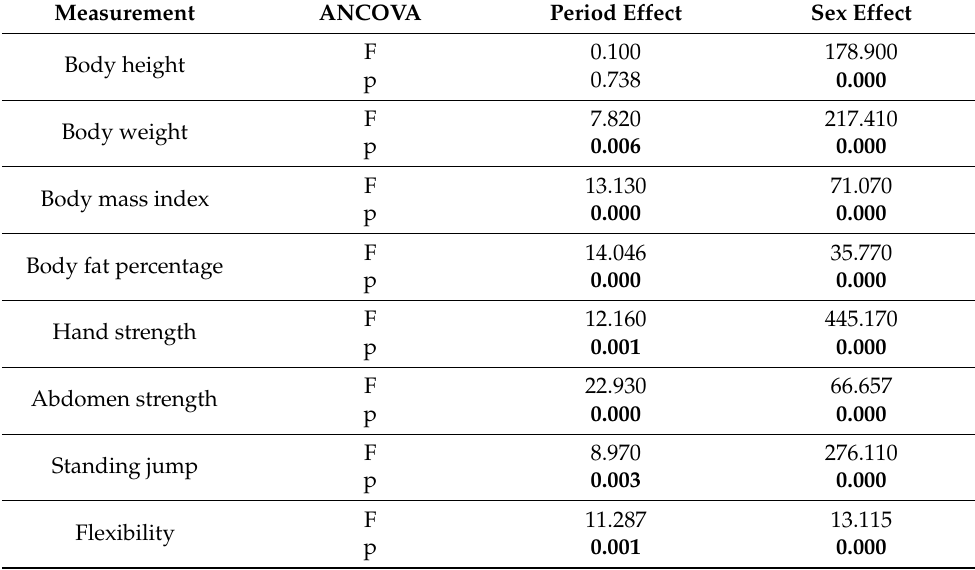
Table 3. Results of ANCOVA (F-ratio and corresponding p -values).